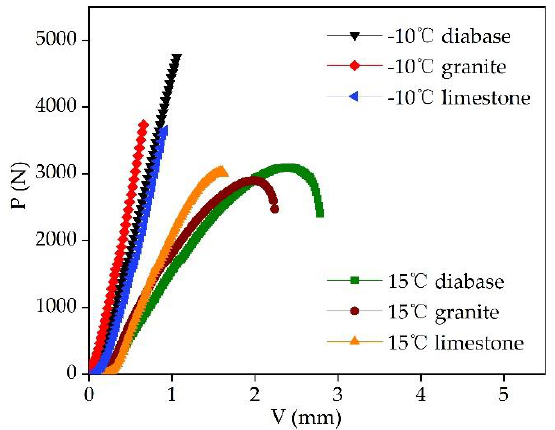
Figure 10. Load–displacement curves for the different EACs.